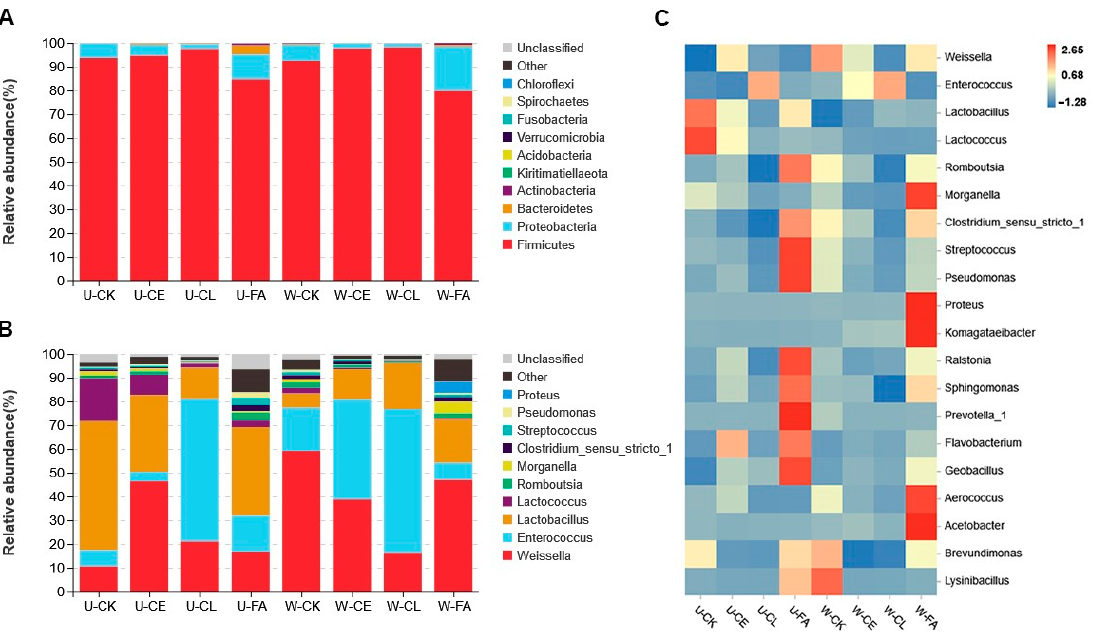
Figure 3. Relative abundances of bacterial communities at the levels of phylum ( A ) and genera ( B ). Correlation analysis of the bacterial genus with the different treatments ( C ). U, wilt 0 h; W, wilt 3.5 h; CK, control (no additives); CL, Enterococcus durans ; CE, cellulase; and FA, formic acid.